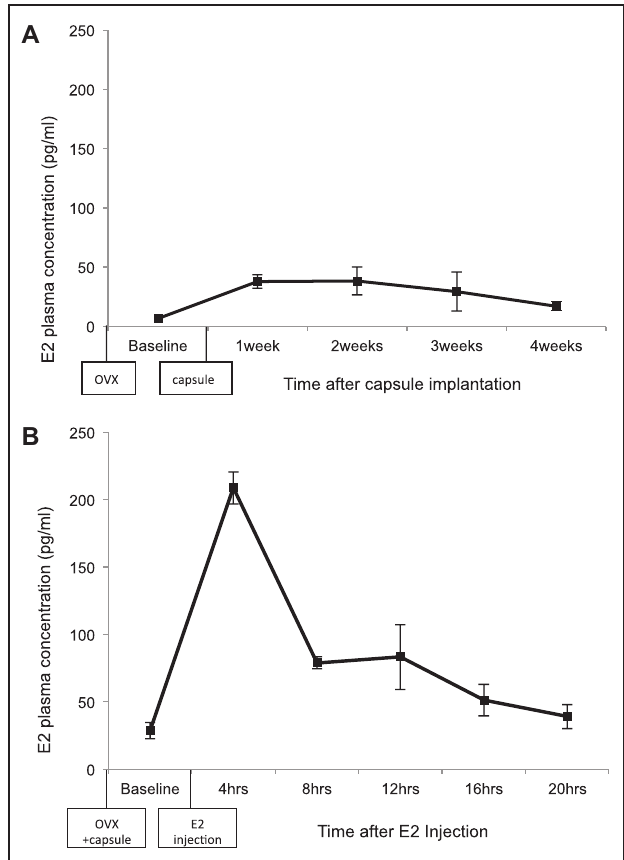
FIGURE 2 | Estradiol (E2) plasma levels following : (A) ovariectomy and implantation of a silastic capsule containing 5% 17-beta E2 and cholesterol. (B) Ovariectomy, implantation of a silastic capsule, and a 10 µ g/kg SC injection of E2, dissolved in sesame oil. The error bars represent standard error of the